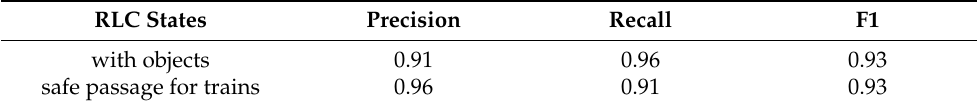
Table 3. Determination of the RLC states using